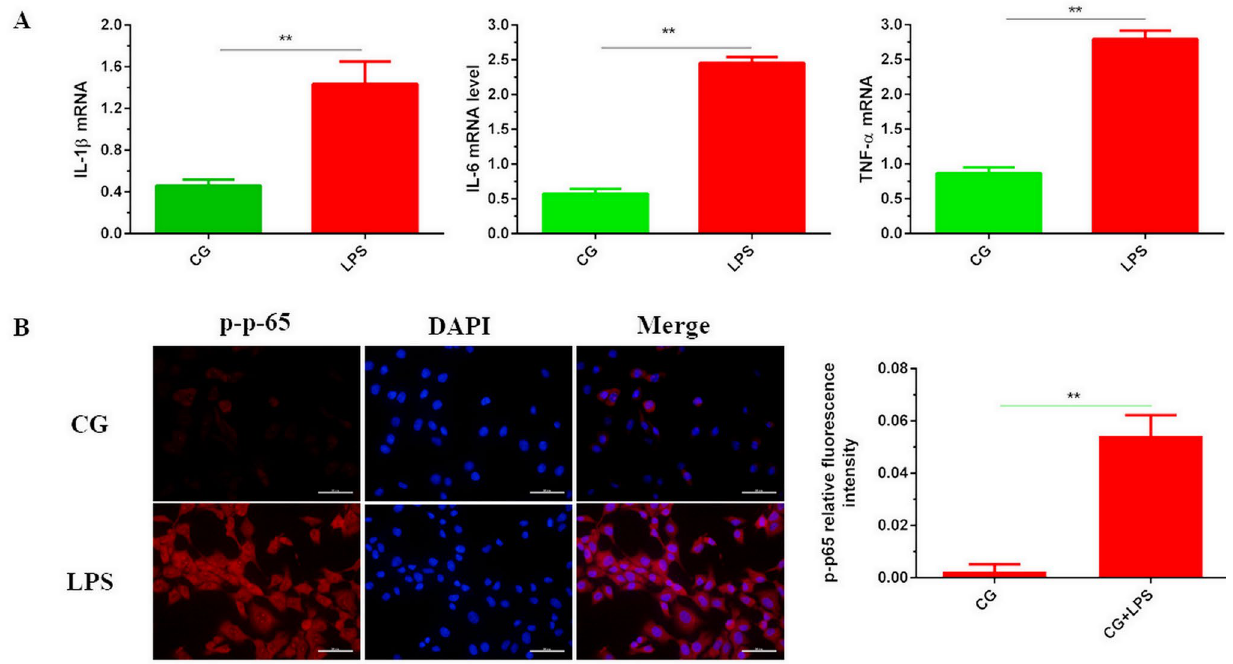
Figure 2. Construction of bEECs inflammatory injury model. ( A ) The levels of TNF-α, IL-1β and IL-6 were detected using qPCR in bEECs. CG is set as the control group; LPS is the model group. ( B ) The phosphorylation level of p65 was revealed by immunofluorescence experiment (× 400, scale = 50 μm); p-p65 was stained with red and the nucleus was blue. Image-Pro Plus (IPP) 6.0 software calculated IOD/area, and indicated the fluorescence intensity of p-p65. Data are expressed as mean ± S.D., three independent experiments. * p < 0.05; ** p < 0.01.